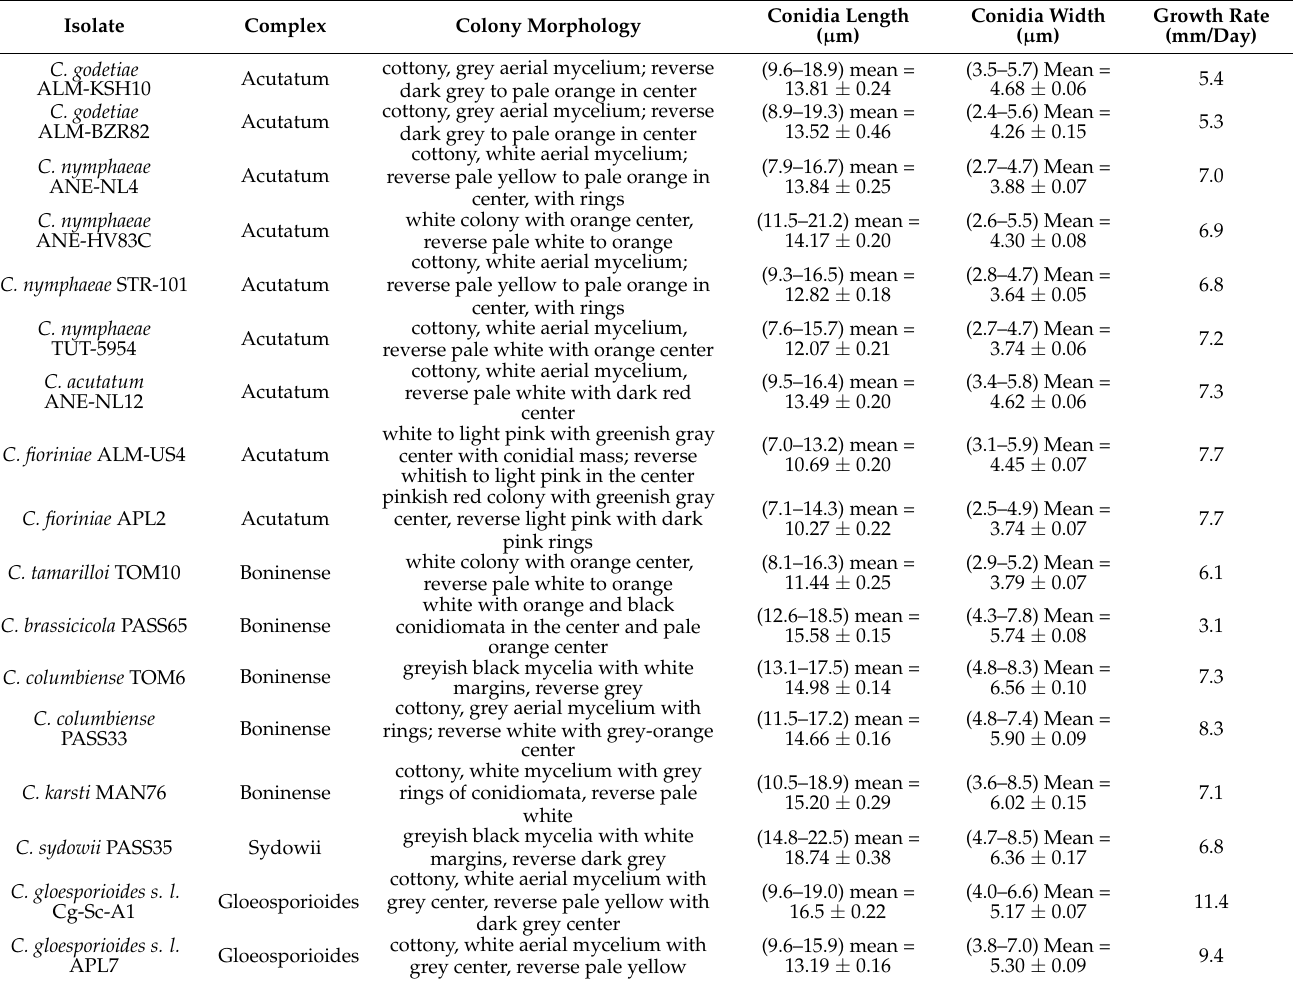
Table 1. Colony morphology and growth rate on PDA and conidial characteristics of the representa- tive Colletotrichum species from this